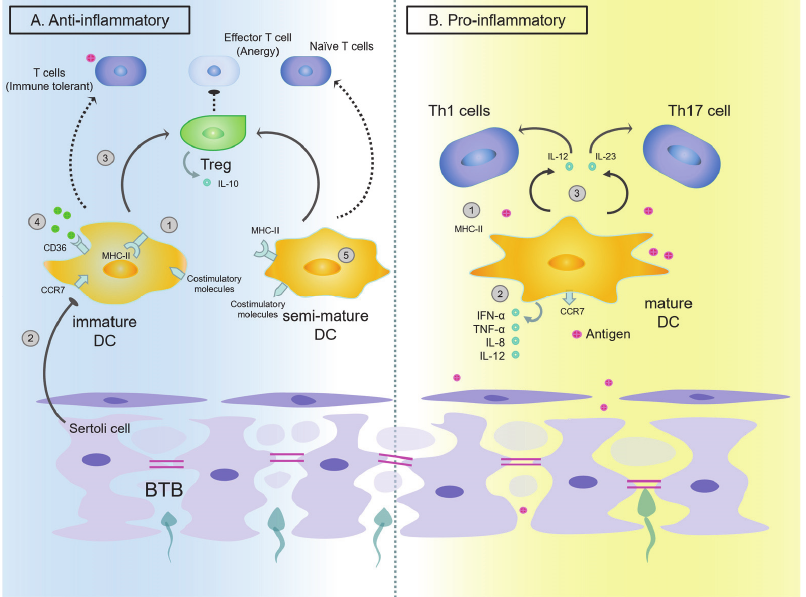
Figure 2. Regulation of testicular DC in physiological conditions (mainly anti ‐ inflammatory) and pathological conditions (mainly pro ‐ inflammatory). ( A ) Under physiological conditions, the DCs in